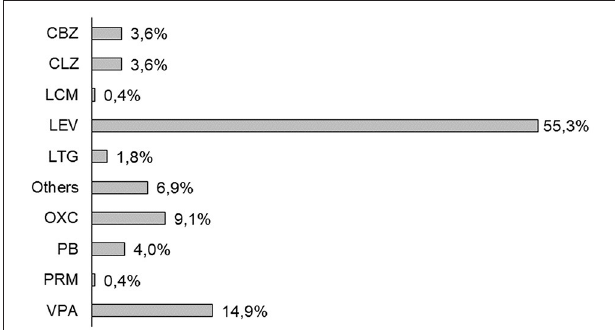
FIGURE 1 | First antiseizure medication (ASM) prescription in post-stroke epilepsy (PSE) cohort (2013–2019). CBZ, carbamazepine; CLZ, clonazepam; LCM, lacosamide; LEV, levetiracetam; LTG, lamotrigine; OXC, oxcarbazepine; PB, phenobarbital; PRM, primidone; and VPA,